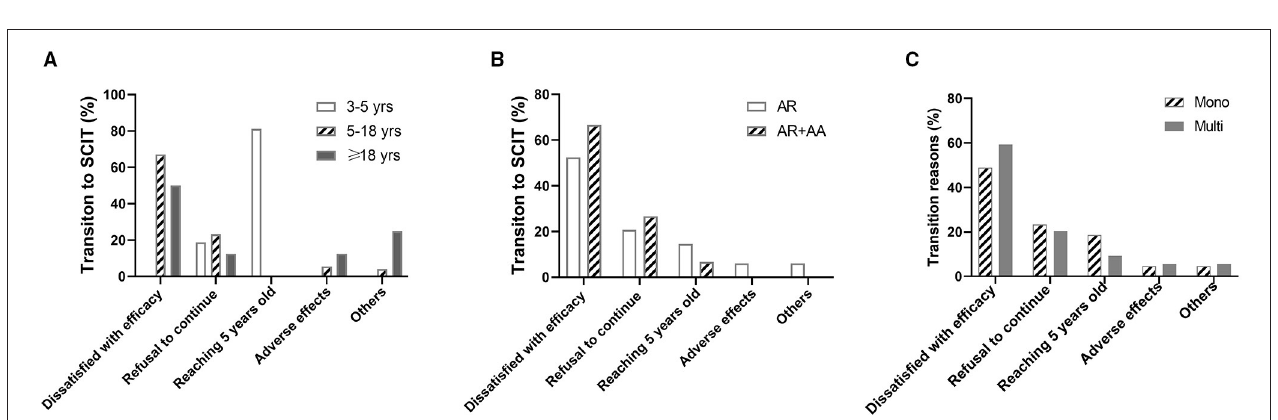
FIGURE 5 | Proportions of SLIT to SCIT transition in AR patients with or without AA (A) . Patients with different sensitization statuses (B) . AR: allergic rhinitis; AA: allergic asthma. Mono: sensitized only to HDM; multi: sensitized to other aeroallergens in addition to HDM. * P < 0.05; ** P < 0.01; # P < 0.001.